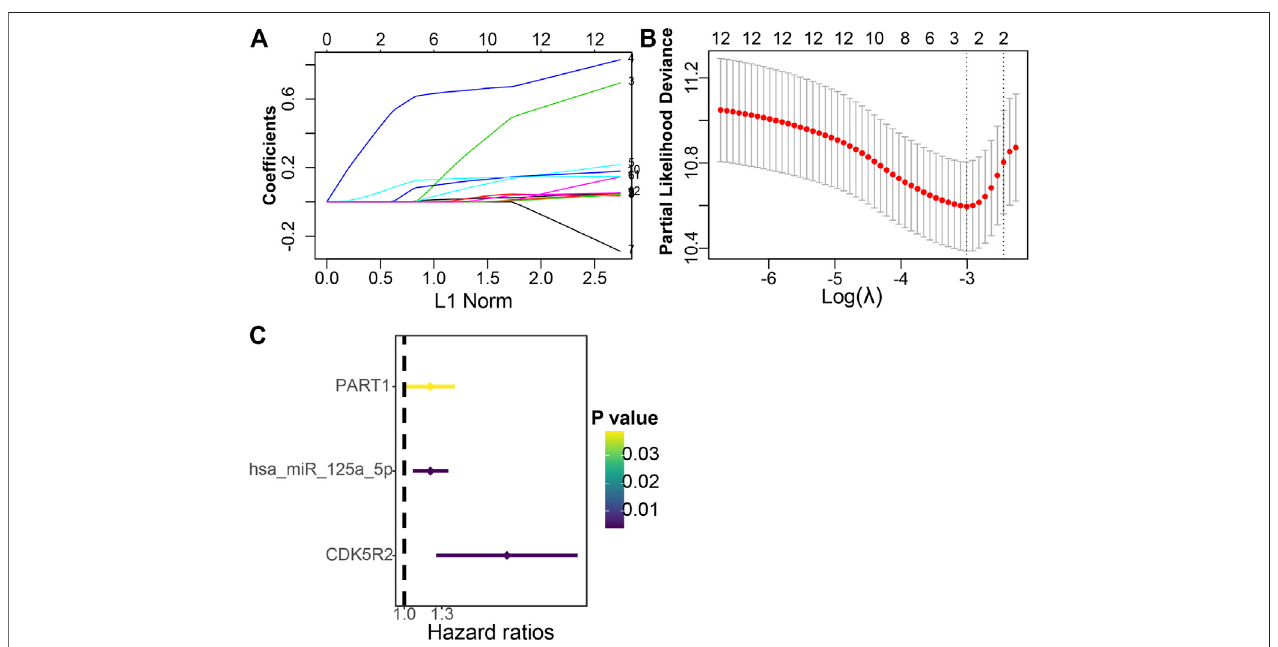
FIGURE 5 | Establishment of the prognostic risk signature. (A) LASSO coef fi cient pro fi les of 12 candidate genes. A vertical line is drawn at the value selected through10-fold cross-validation. (B) Theverticallines areplottedonthebasisoftheoptimal datainaccordancewiththeminimumcriteria and 1-standard errorcriterion. The left vertical line represents the three genes fi nally identi fi ed. (C) Forest plots indicate the relationships of each gene subsets with OS. The unadjusted HRs are presented with 95% CIs.